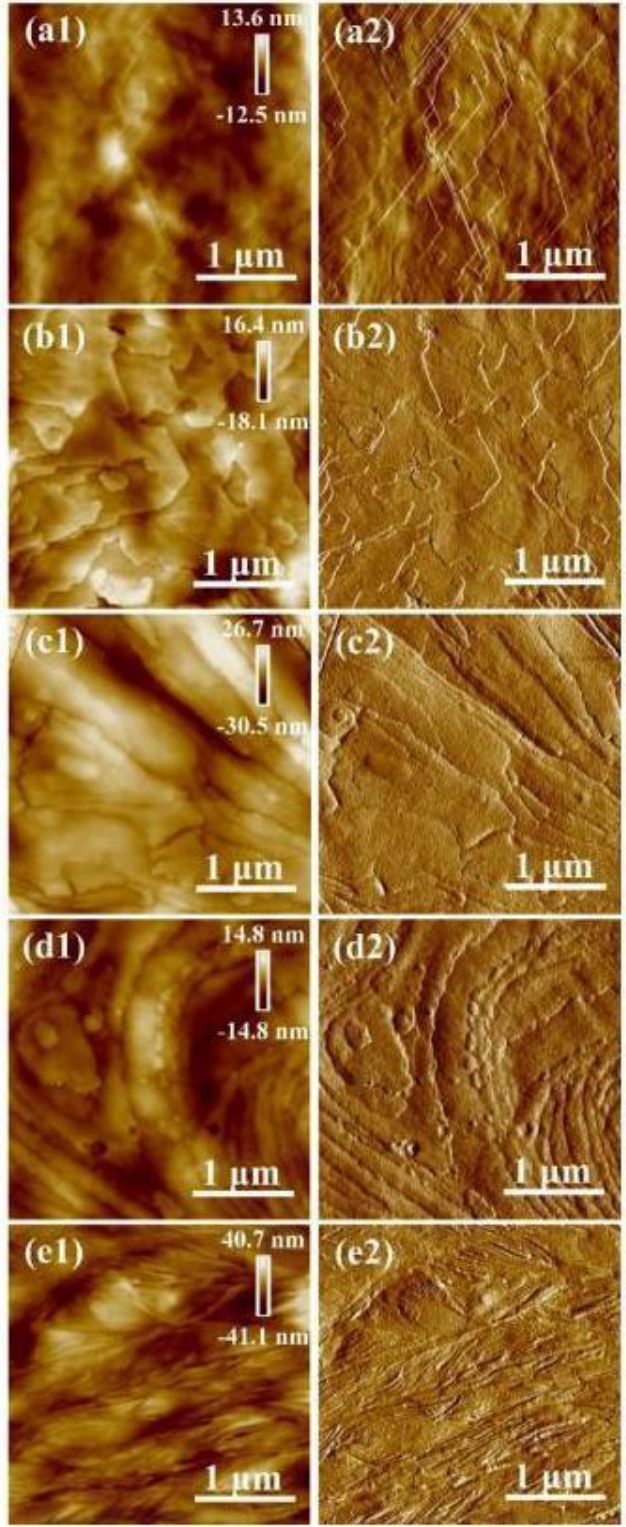
Figure 2. AFM images of the crystal surface of PLLA samples after crystallization treatment at a temperature of 80 ◦ C: ( a1 – e1 ) show the height images of PLLA1, PLLA2, PLLA3, PLLA4 and PLLA5, respectively; ( a2 – e2 ) show the peak force error images of the five PLLA samples,